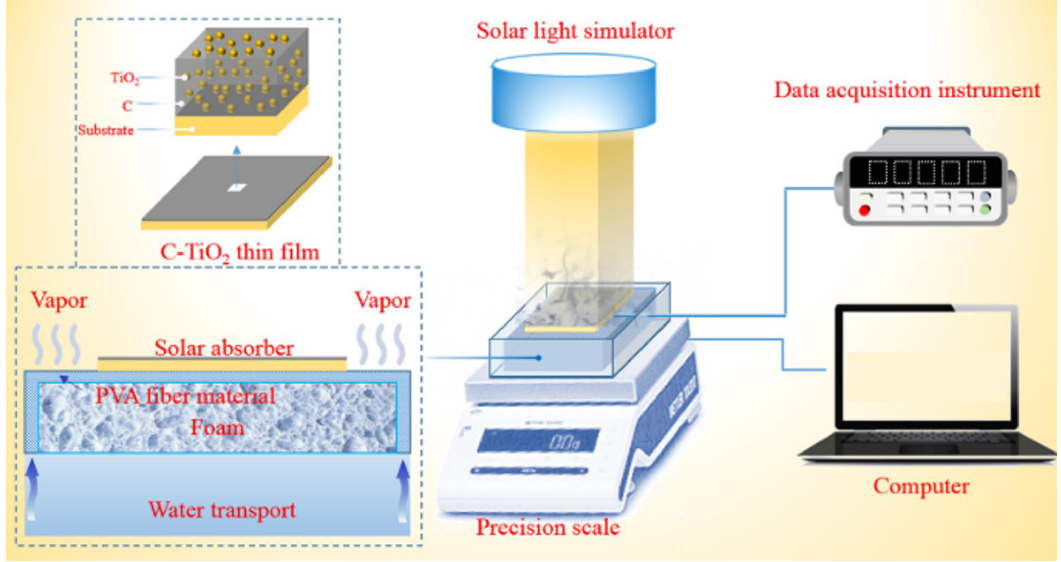
Figure 26. Experimental schematic of the C-TiO 2 solar water evaporator [94]; 2019, Elsevier.